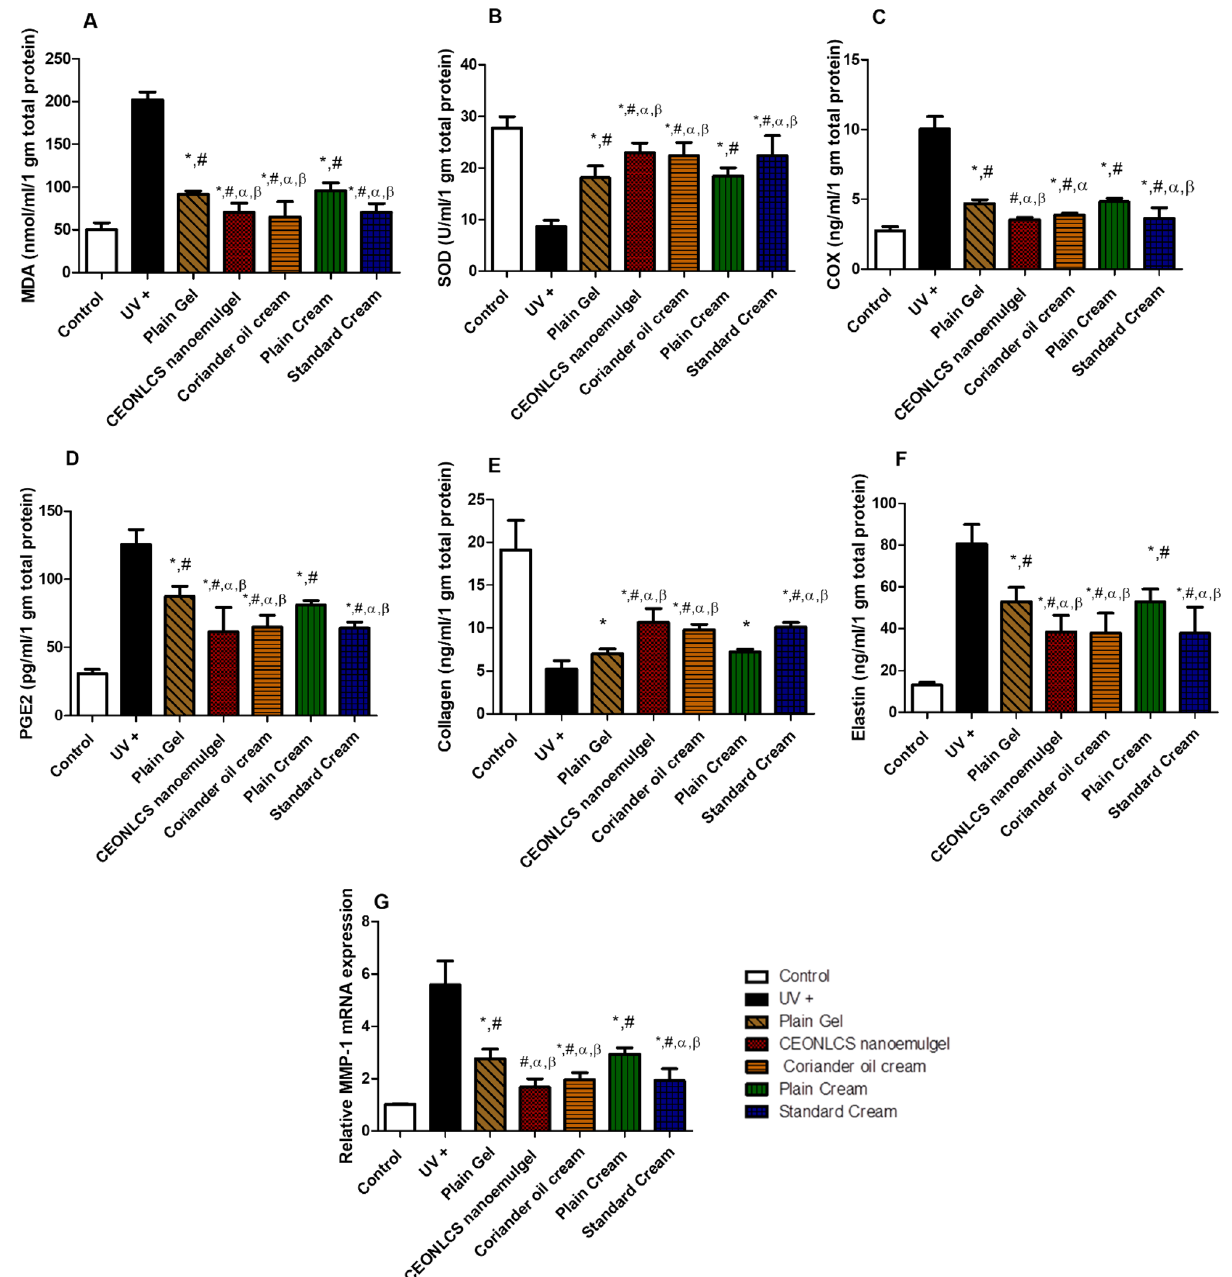
Figure 3. Effect of plain cream, plain gel, Coriander oil cream formula, CEONLC nanoemulgel formulation, and standard cream treatment on levels of ( A ) MDA, ( B ) SOD, ( C ) COX-2, ( D ) PGE-2, ( E ) Collagen, ( F ) Elastin and MMP-1 ( G ), in skin homogenates of photoaged mice. Each result represents the mean value for 8 mice ± SD of the mean. Statistical analysis was carried out by one-way ANOVA followed by Tukey’s multiple comparison test. *Statistically significant from the normal control group at p ≤ 0.05, # statistically significant from the UV injured group at p ≤ 0.05, α statistically significant from the plain cream base group at p ≤ 0.05, and β statistically significant from the plain gel base group at p ≤ pared to UV injured group at p < 0.05. There was no significant difference in the all-previous biomarkers tissue levels among coriander oil cream, CEONLC nanoemulgel formulation, and standard cream (Fig. 4). The external appearance of the dorsal skin in the different experimental groups. Coriander oil in both cream and CEONLC nanoemulgel formulation improve the skin appearance as compared to UV-injured group (Fig. 5).